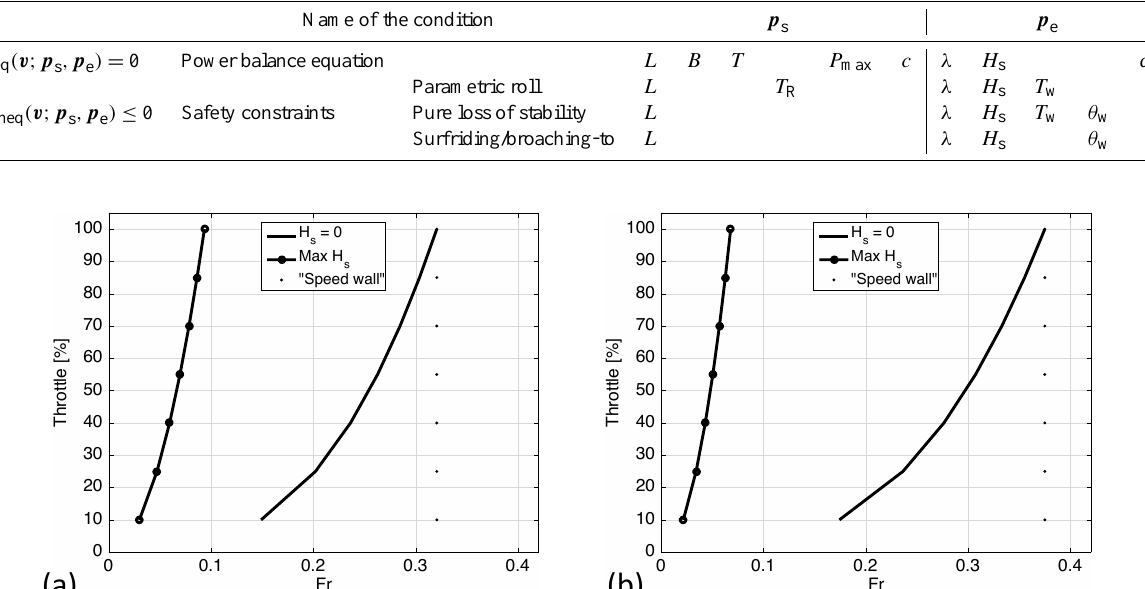
0”) and both calm and wave added resistance =